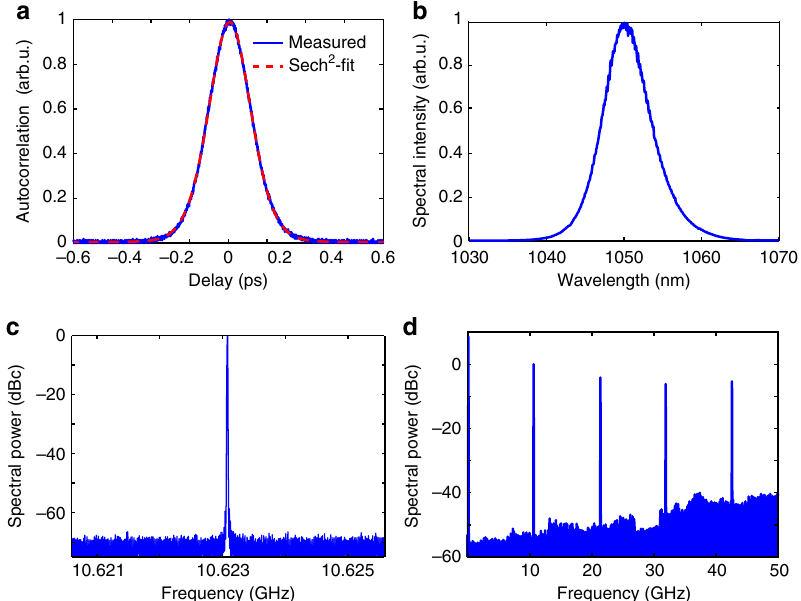
Fig. 3 Modelocking characterization of the 10-GHz Yb:CALGO laser at 1.2 W of average output power. a Intensity autocorrelation of the transform-limited 166 fs pulses. b Optical spectrum centred at 1050 nm with a bandwidth of 7 nm (full width at half maximum, FWHM) measured with a resolution bandwidth (RBW) of 0.08 nm. c 5-MHz span microwave spectrum recorded with an RBW of 3 kHz showing the repetition rate signal at 10.62 GHz d 50- GHz span microwave spectrum recorded with an RBW of 100